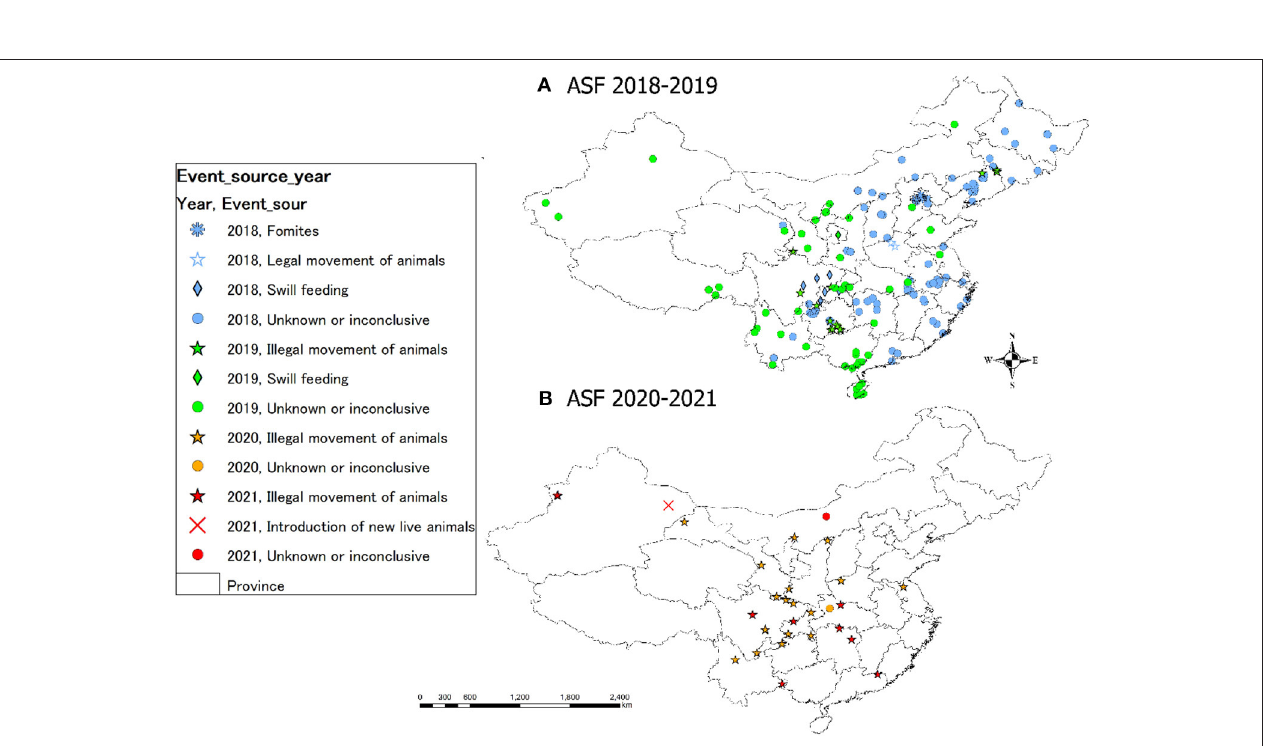
FIGURE 2 | Spatial distribution of ASF in China. Each ASF notification was classified by event source; maps (A) and (B) show the situation of outbreaks in 2018–2019 and in 2020–2021, respectively. These information sources are based on official reports to the OIE.